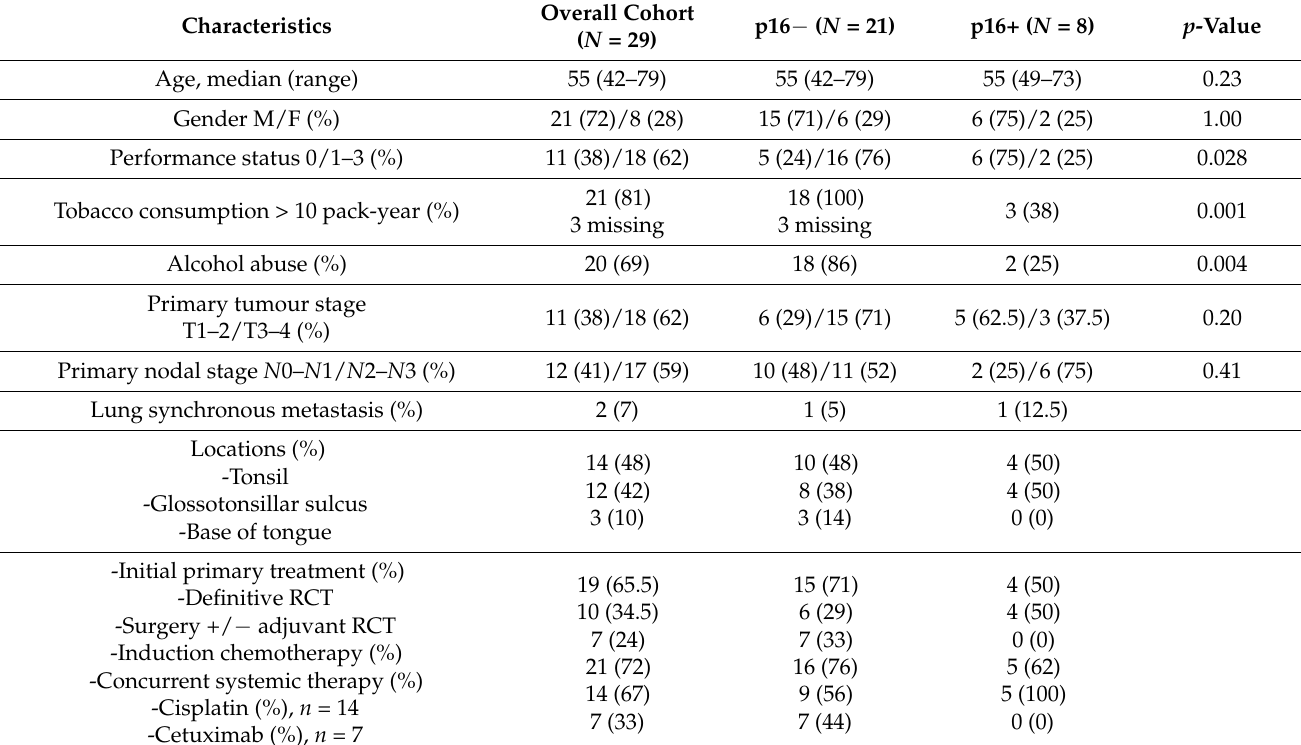
Table 1. Demographics, disease and treatment characteristics of metastatic patients ( n = 29) and according to p16 status.